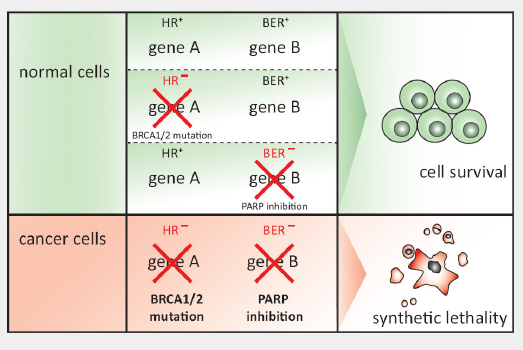
perturbations in two or more genes that leads to cell death, whereas inactivation of any one of the genes alone does not. Perturbation of genes can occur through genetic mutation or silencing, depletion by RNAi or inhibition by SMIs and is depicted by a red cross. If genes that are essential for a certain DNA repair pathway (e.g. gene A) are inactivated in normal cells, alternative pathways with functional genes (e.g. gene B) are utilised to respond to DNA damage. Conversely, cancer cells mutated or silenced for a component of a DDR pathway are compromised in their ability to process DSBs. These cells then rely on alternative DNA repair pathways to repair the breaks. Therefore, inhibition of the alternative pathway will cause cell death due to persisting DSBs. Please refer to main text for details about the example given for synthetic lethality between BRCA1/2 mutation and PARP inhibition. ADP = adenosine diphosphate; BER = base excision repair; DDR = DNA damage response; DNA = deoxyribonucleic acid; DSB = double-strand break; HR = homologous recombination; PARP = poly(ADP-ribose) polymerase; RNA = ribonucleic acid; RNAi = RNA interference; SMI = small molecule